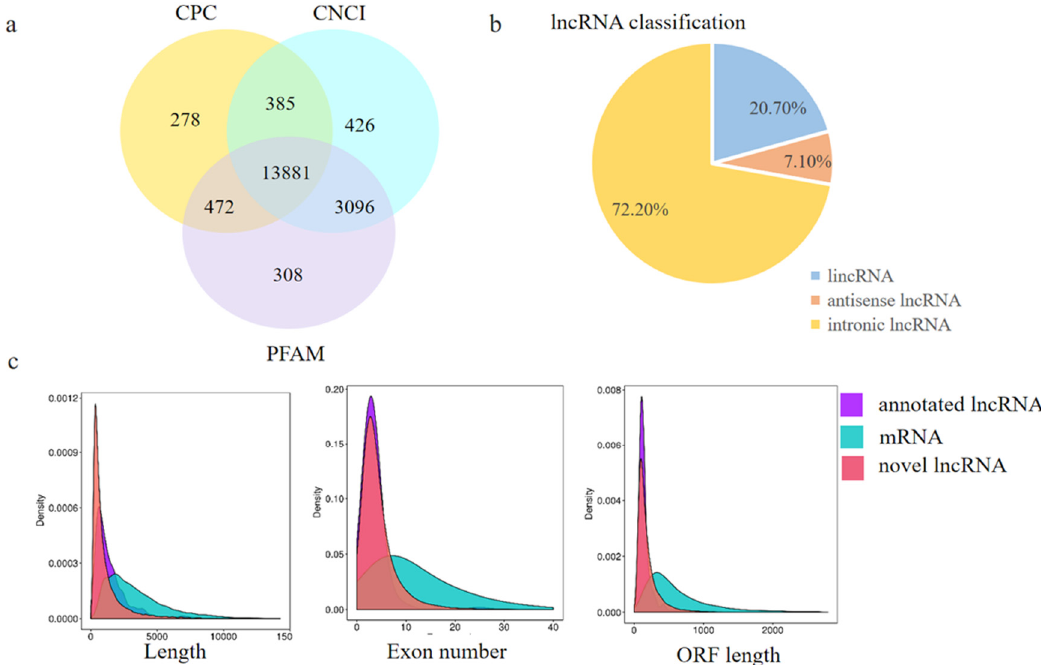
Figure 6. Identification and characterization of lncRNAs in E 65 and E 120 skin tissues of Capra hircus . ( a ) Screening of the candidate lncRNAs in the skin transcriptome by CPC, CNCI, and PFAM. ( b ) The classification of lncRNAs. ( c ) Distribution of the transcript lengths, exon number, and open reading frame (ORF) length in the lncRNAs and protein-coding transcripts. In total, 1407 annotated lncRNAs and 13,881 novel lncRNA loci, including long intergenic non-coding RNA (lincRNAs), intronic lncRNA, and anti-sense lncRNAs, were identified. Compared with protein coding transcripts, lncRNAs showed a shorter ORF length and transcript length, and a lesser exon number.